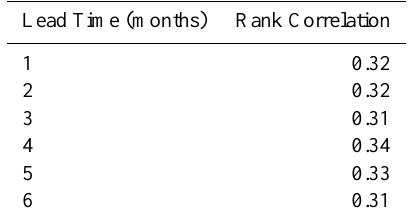
Table 1. Rank correlations between monthly time series of average precipitation from selected 7 ECHAM 4.5 grids for 1–6 month lead times and spatially averaged (monthly) observed precipitation over the study area during the period from 1957 to